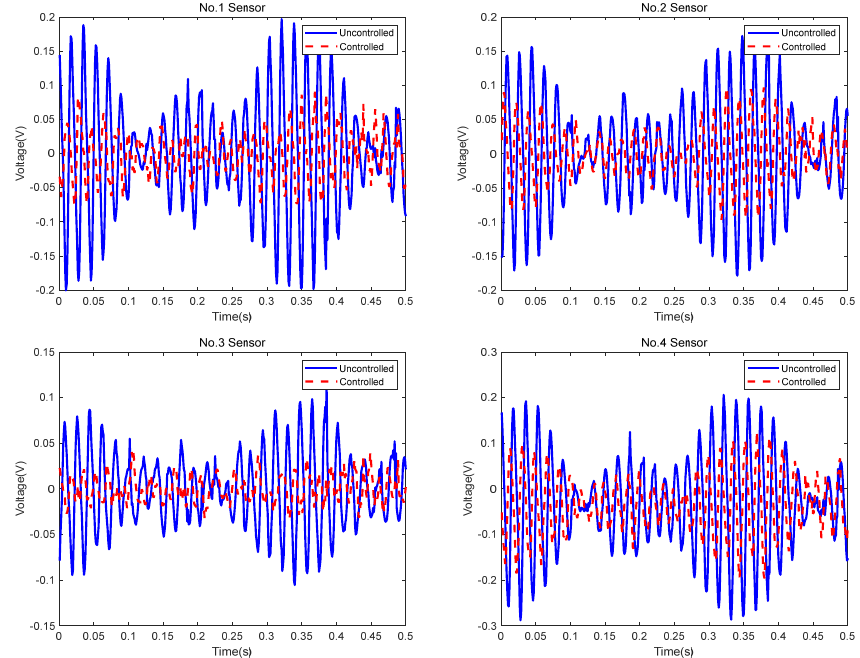
Table 6. Peak values of PSD curves of sensor signals: Experiment #2.